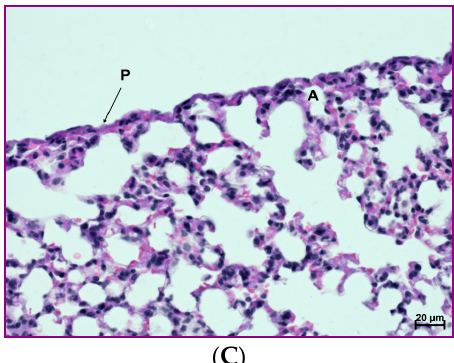
Figure 11. Protective effect of the 4B8M peptide on histological changes in the model of OVA-induced pleurisy: the experiment was performed as described in Figure 9, but mice were given 4B8M 250 µg i.p. ( A ) Lung of the naive (BG) mice: normal appearance. ( B ) Lung of the mice with fully blown inflammation: interstitial and pleural inflammation. ( C ) Lung of the mice pretreated with 4B8M i.p.: a silencing of the inflammatory processes was observed; detailed description of the histological analysis is in the text. Abbreviations: P—pleura, A—pulmonary alveolus; magnification 400×; scale bars, 20 µm.